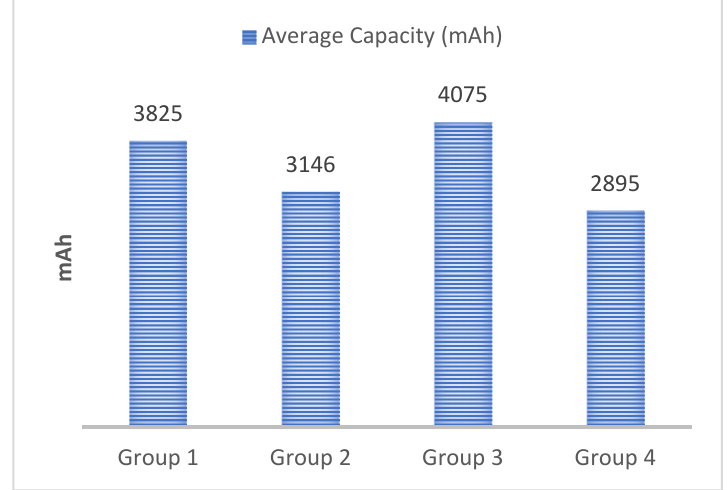
Figure 3. Average charge capacity for each battery group.